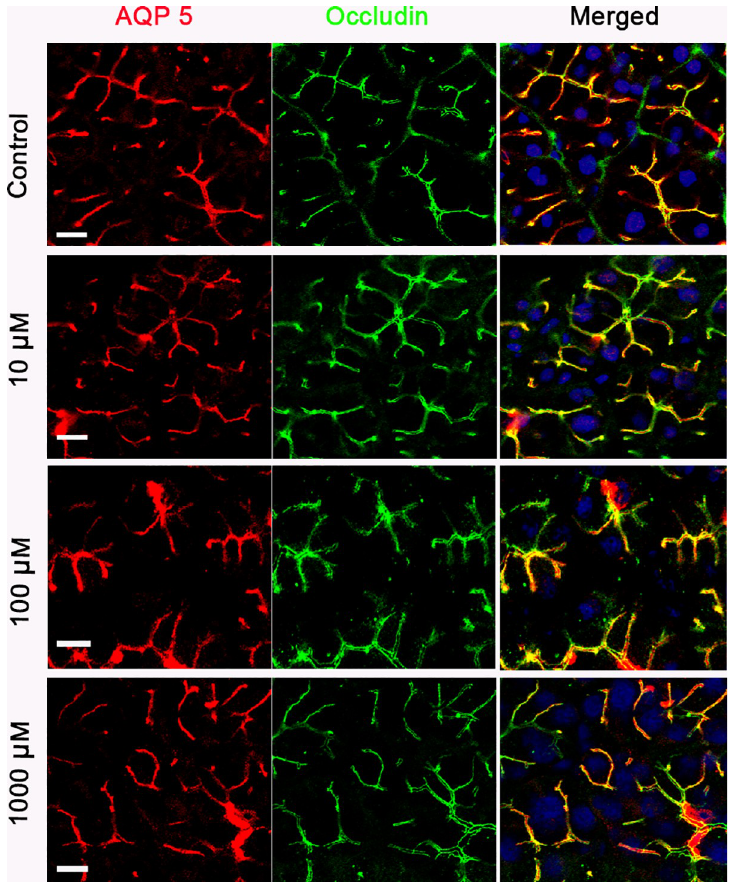
Fig 3. Pilocarpine stimulation had no effect on the subcellular structures of perfused submandibular glands of rats. Submandibular glands were perfused with perfusate containing 0 (Control) -1000 μ M pilocarpine for 5 min, and were sectioned by cryostat. Sections were stained with anti-aquaporin 5 conjugated with Alexa Fluor 568 (red), anti- occludin conjugated with Alexa Fluor 488 (green), and TO-PRO3 to detect the nuclei (blue). Results are representative of three independent